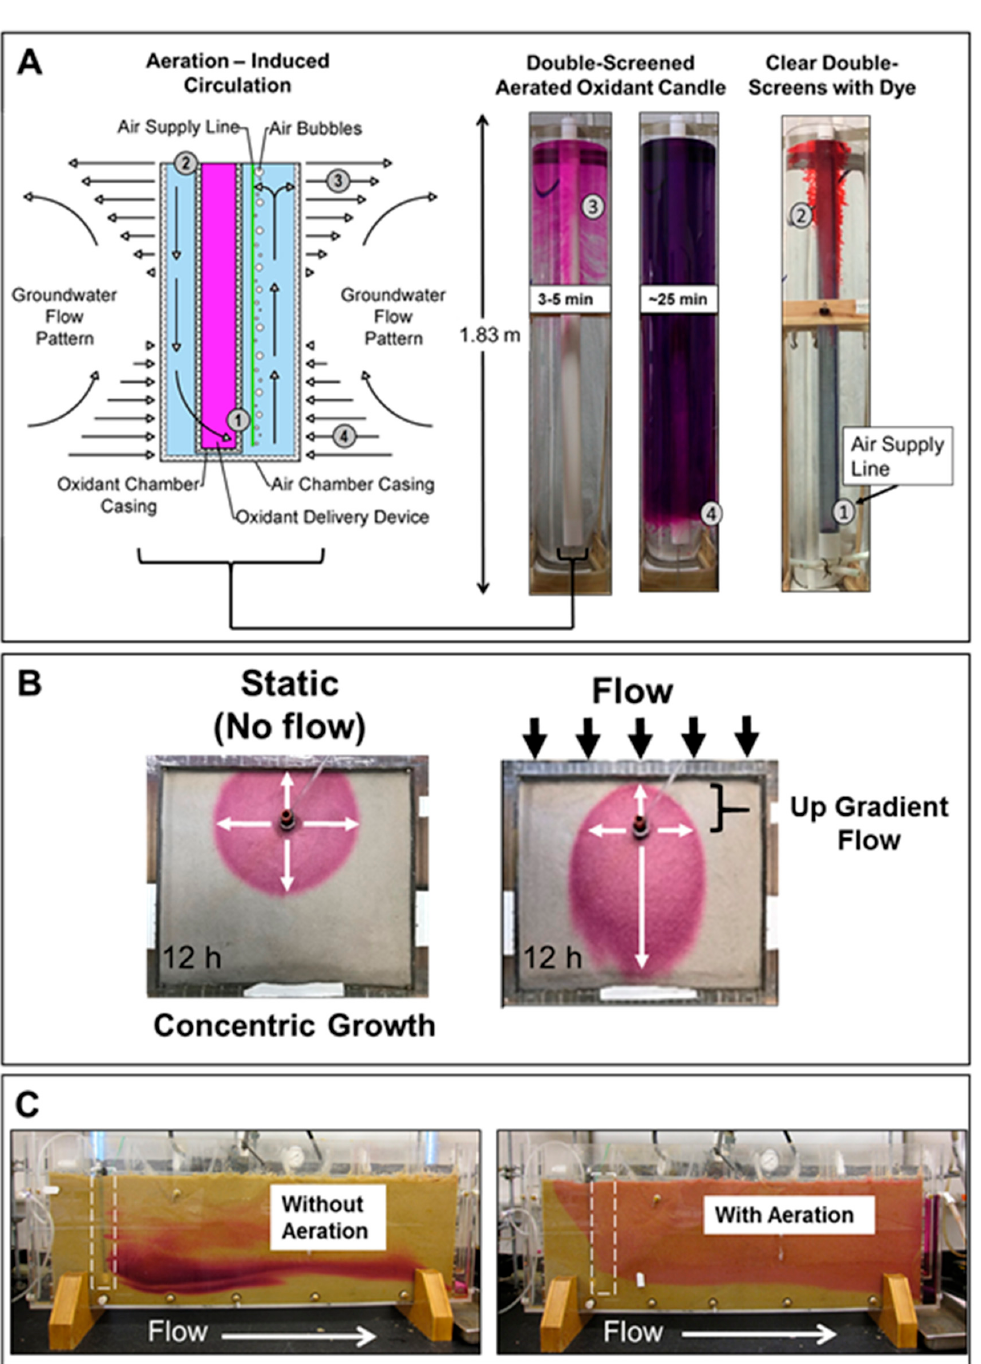
Figure 2. ( A ) Schematic illustrating observed flow patterns and temporal side-view photographs of oxidant dispersal patterns from field-scale, aerated oxidant candles; ( B ) top view of wide flow box (35.6 cm W × 30.5 cm L, see Figure S3) showing permanganate spreading from miniature double-screened candles after receiving similar aeration rates for 12 h, one with advection and one without (static) and ( C ) photographs of narrow flow box (122 cm W × 45 cm H) containing permanganate candle under advection, with and without aeration.